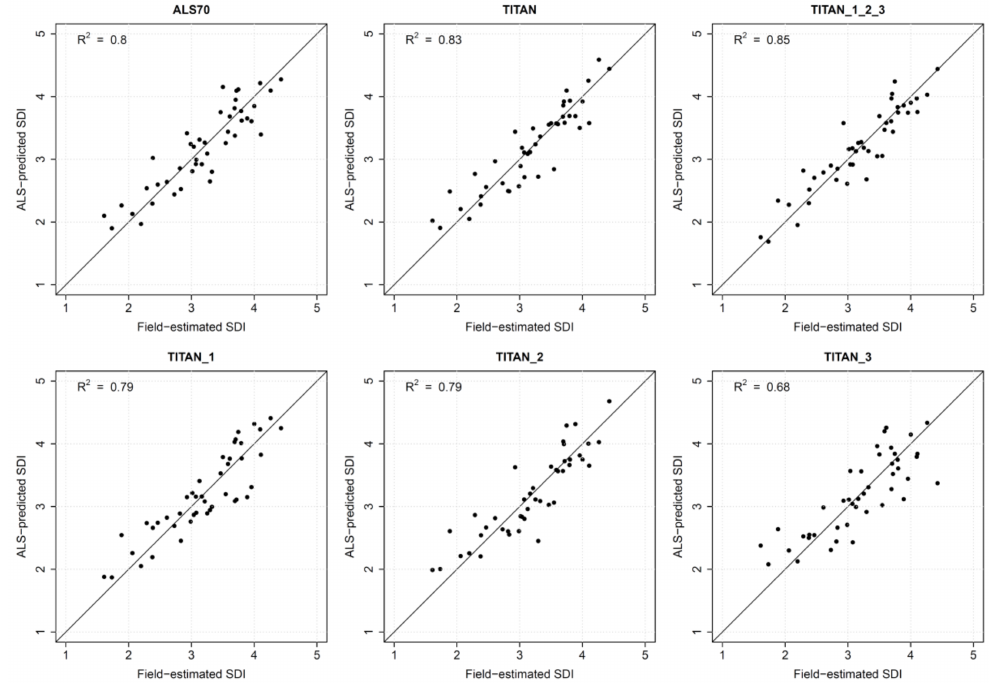
Figure 6. Scatterplots of the field-estimated and ALS-predicted values of the Shannon diversity index ( SDI ) for each sub-plot for each model. In each scatterplot the Pearson’s correlation coefficient between the observed and predicted values is